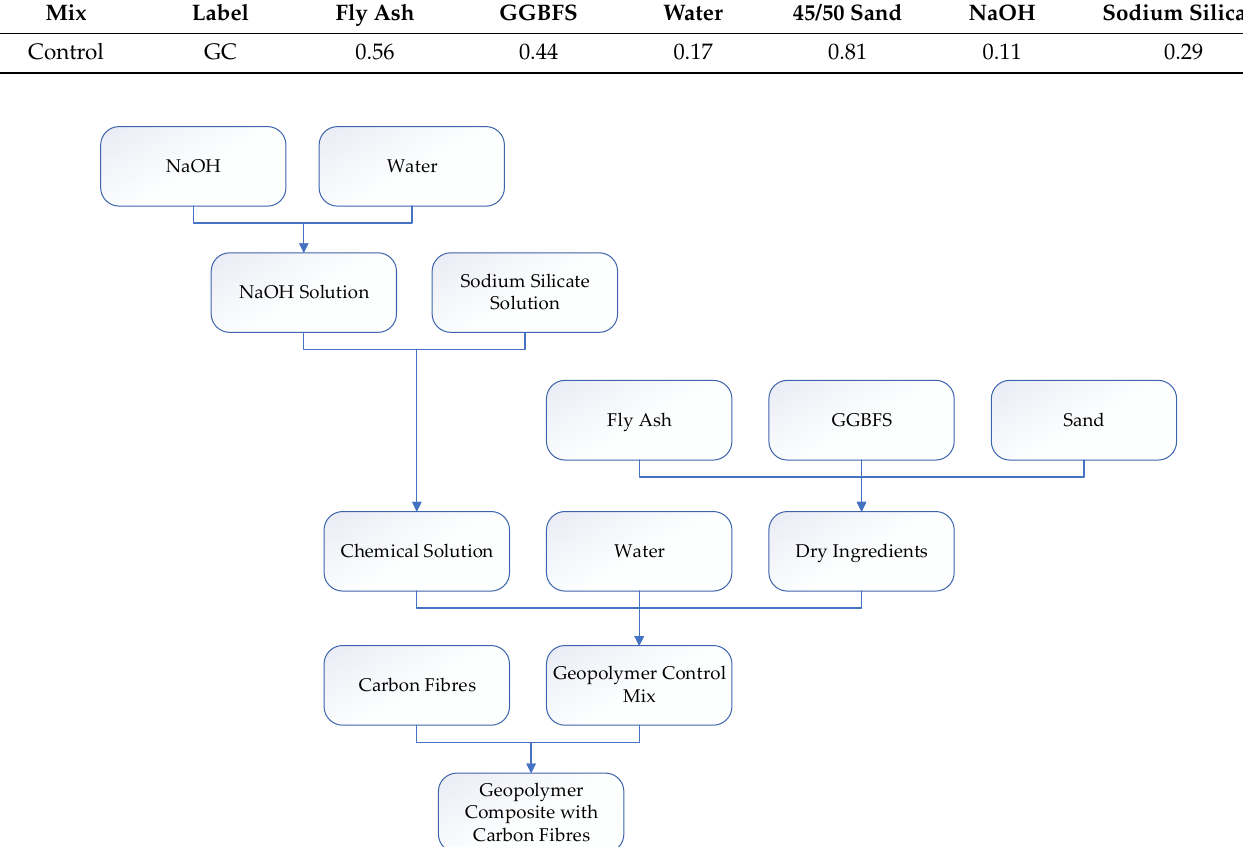
Figure 2. Flow chart of the fabrication process of the geopolymer composites .